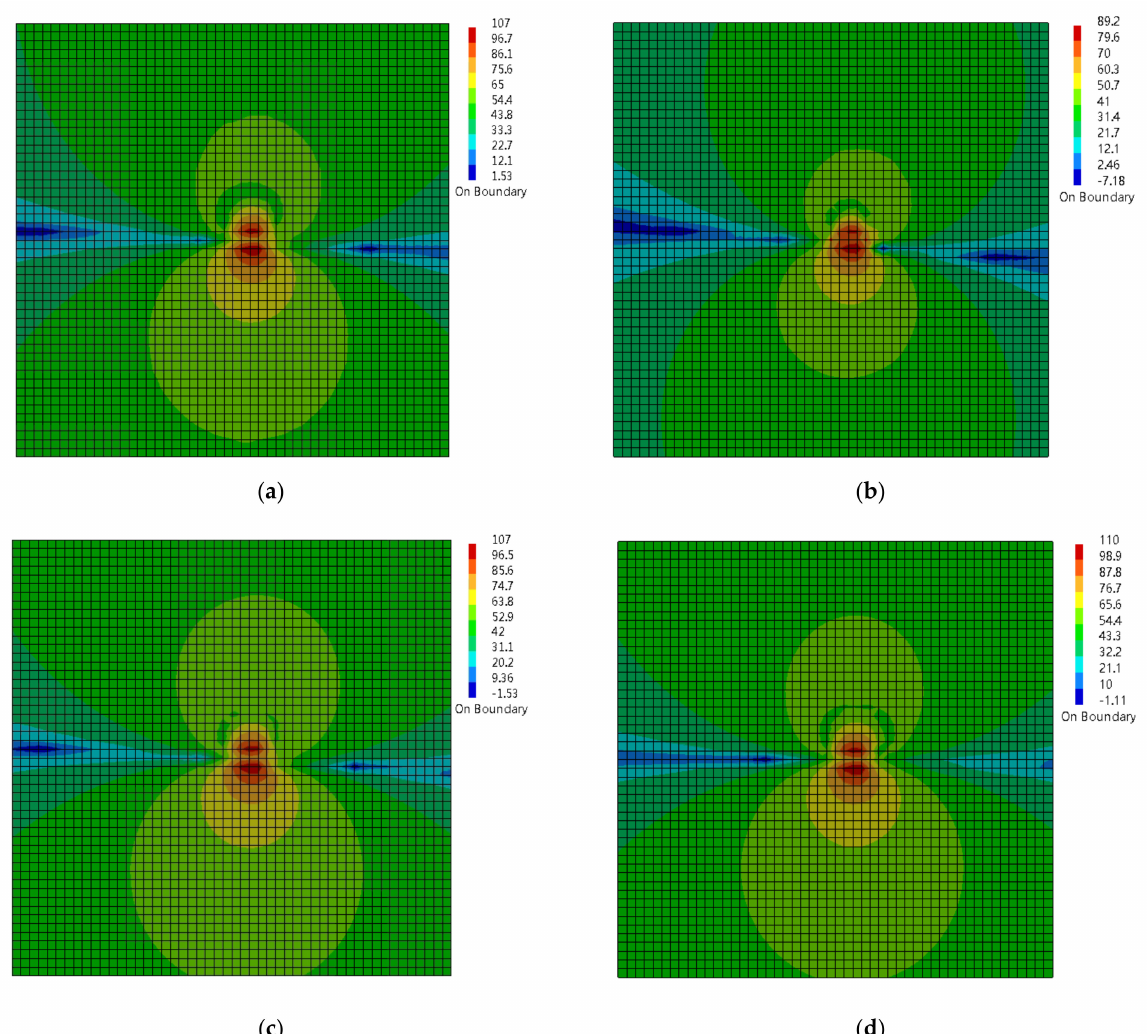
Figure 13. Acoustic radiation field in the yoz plane (50 Hz): ( a ) no damping; ( b ) damping on the plate; ( c ) damping on the web; ( d ) damping on the ribbed